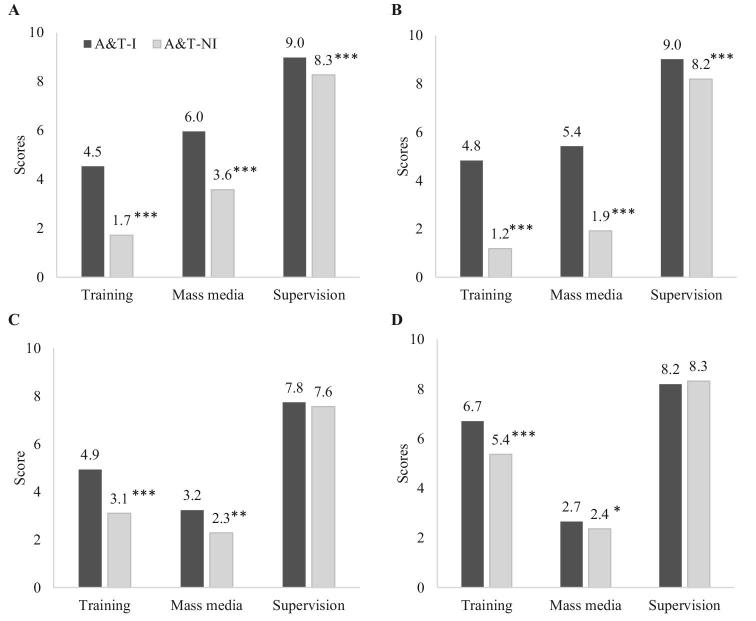
Exposure to intervention design elements among frontline health workers, by program group, in Bangladesh and Vietnam. Bangladesh SK (A), Bangladesh SS (B), Vietnam HS (C), and Vietnam VHW (D). All intervention exposures are presented as scores with a range of 0–10 (see Supplemental Table 1 for details). *, **, ***Significant difference between intensive and non-intensive areas, accounting for geographic clustering: *P < 0.05, **P < 0.01, ***P < 0.001. A&T-I, Alive & Thrive–intensive; A&T-NI, Alive & Thrive–non-intensive; HS, health staff; SK, Shasthya Kormi; SS, Shasthya Sebika; VHW, village health worker.